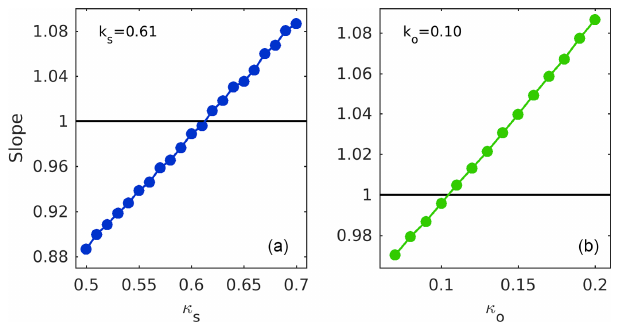
Figure 8. Slope of measured vs. calculated α sp plot as a function of the κ of secondary inorganic aerosols ( κ s , a ) and the κ of organic aerosols ( κ o , b ). The line slope = 1 is shown in black. κ s and κ o values for which slope = 1 are